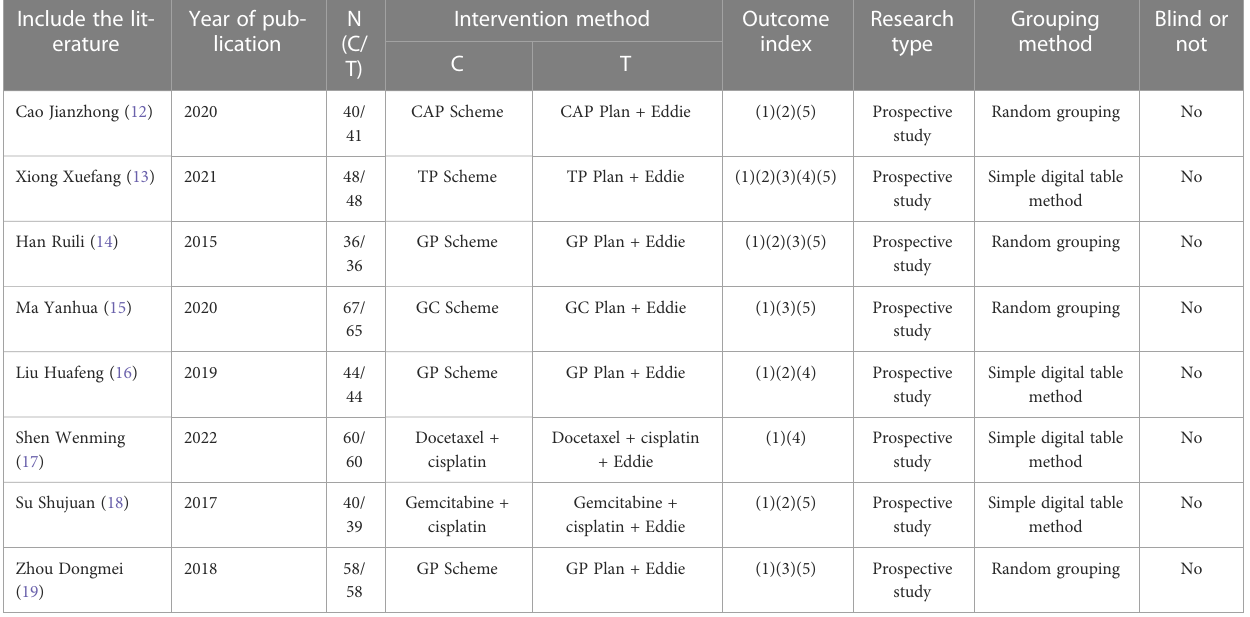
TABLE 1 Basic characteristics of literature.